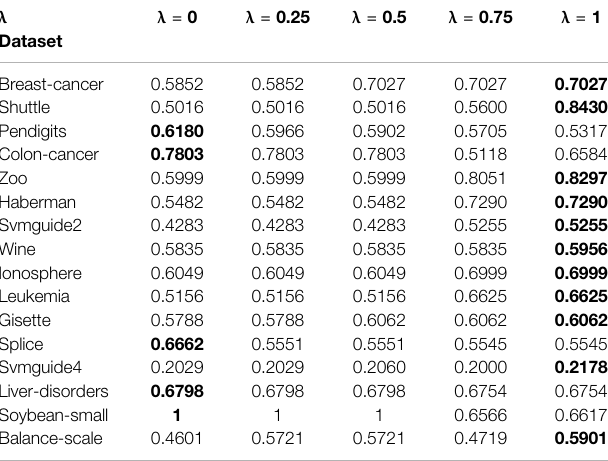
TABLE 5 | AIMK Runs on 16 datasets, Measured by F-Measure. λ